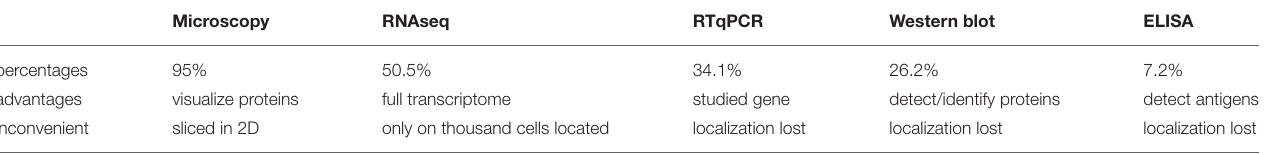
TABLE 2 | Methodology to study cerebral organoids.